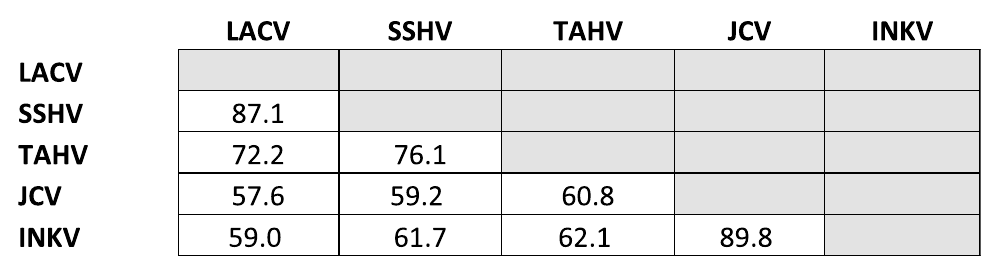
Table 9. Amino Acid identities for the Gc Head